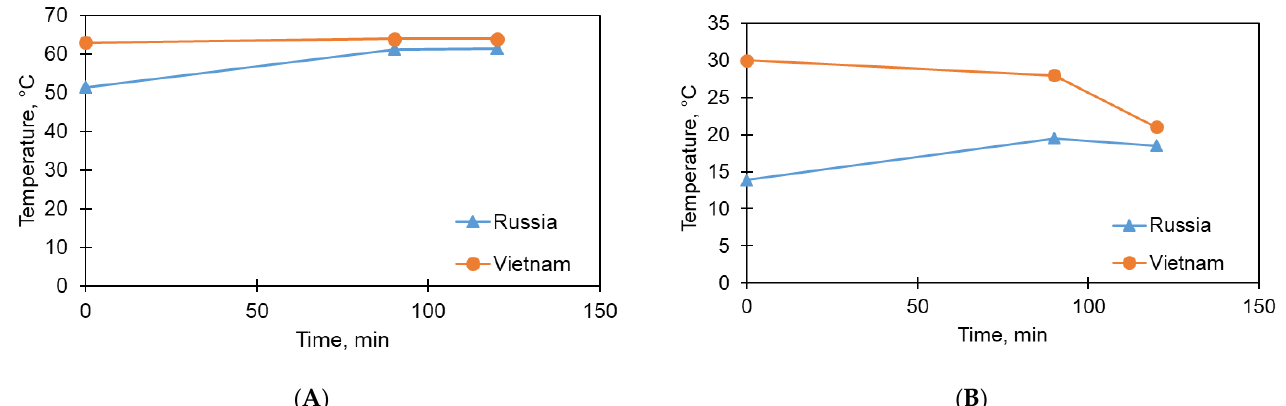
Figure 7. Dependence of the heating temperature of the solution ( A ) and the cooling temperature of the coolant/permeate ( B ) for experiments in Russia (triangles) and Vietnam (circles). the coolant/permeate ( B ) for experiments in Russia (triangles) and Vietnam